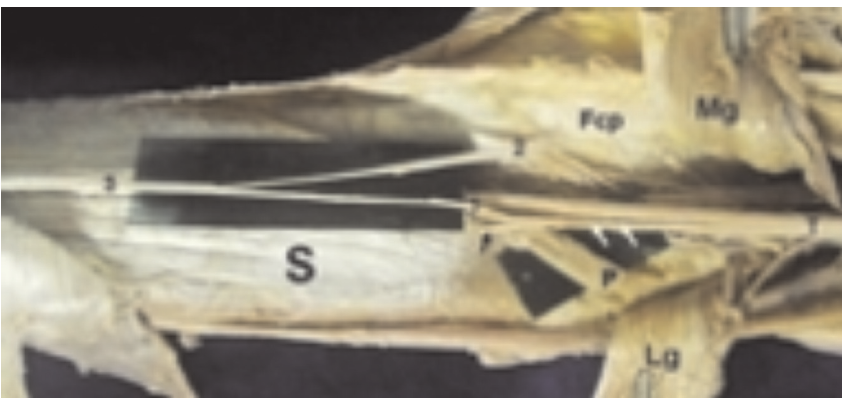
Figure 1 - Popliteal surface and flexor compartment of the right lower leg. Lg, lateral head of gastrocnemius; Mg, medial head of gastrocnemius; Fcp, fascia covering popliteus muscle; P, plantaris muscle; S, soleus muscle; T, tibial nerve; 1, tendon of plantaris; 2, additional tendon of plantaris originating from fascia covering popliteus muscle; 3, common tendon of plantaris. Note the black and white arrows, which indicate the nerve to the soleus that crosses the plantaris muscle belly